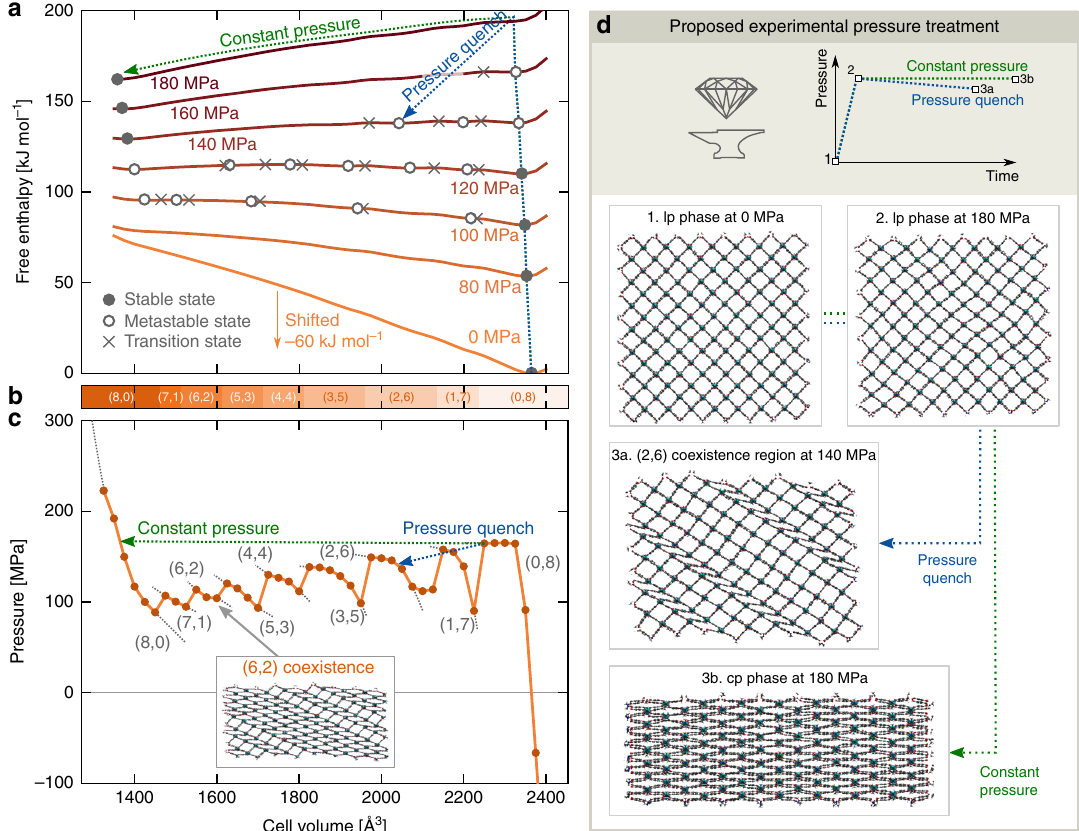
Fig. 4 Using pressure as a stimulus to access the metastable cp/lp coexistence regions in DMOF-1(Zn). a Free enthalpy and c pressure equations of state, with b indication of the metastable ( n , n ) phase coexistence regions as a function of the volume for an 8 × 2 × 8 mesocell of DMOF-1(Zn) at 300 K. The cp lp different (meta)stable states and transition states at different pressures are indicated on the free enthalpy equations of state with (open) circles and crosses, respectively. d The material ’ s response upon two different pressure treatments is predicted: a constant-pressure treatment (green) and a pressure quenching treatment (blue), demonstrating how the latter leads to a stabilized (2,6) phase coexistence. The 0 MPa free enthalpy pro fi le is globally shifted over + 60 kJ mol − 1 to aid the